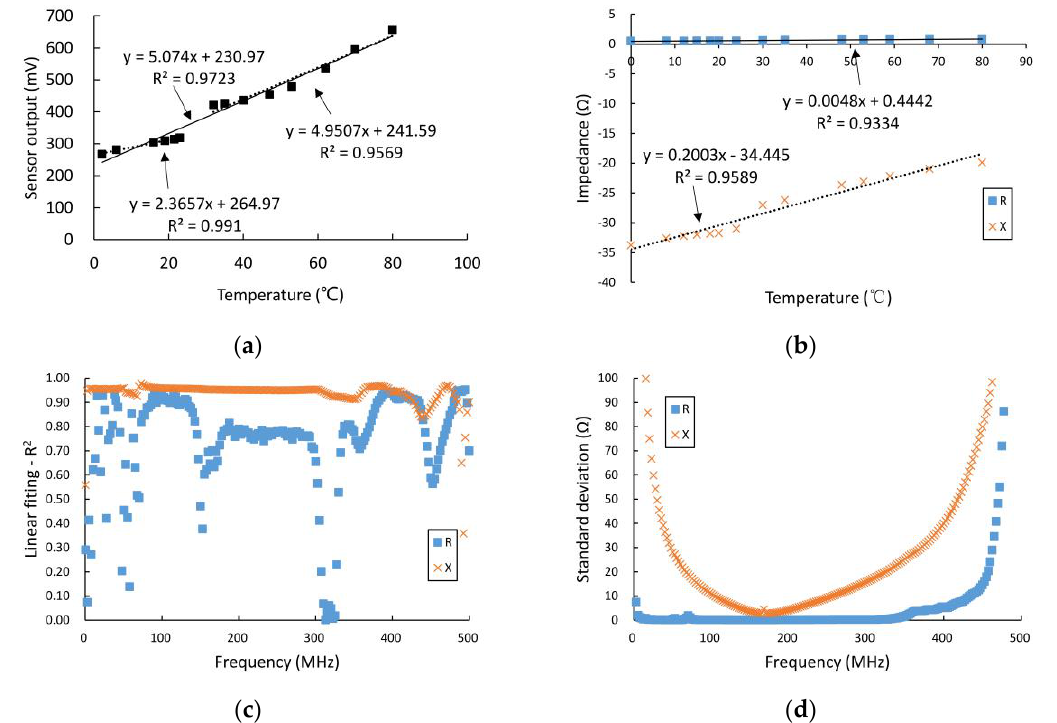
Figure 8. Results of experiments on temperature variation effects. ( a ) The relationship between temperature and differential output voltage from the detection circuit at a frequency of 100 MHz; ( b ) The relationship between temperature and output impedance from the VNA at a frequency of 100 MHz; ( c ) coefficients of determination R 2 in the frequency range from 300 kHz to 300 MHz; and ( d ) standard deviations in the frequency range from 300 kHz to300 MHz.